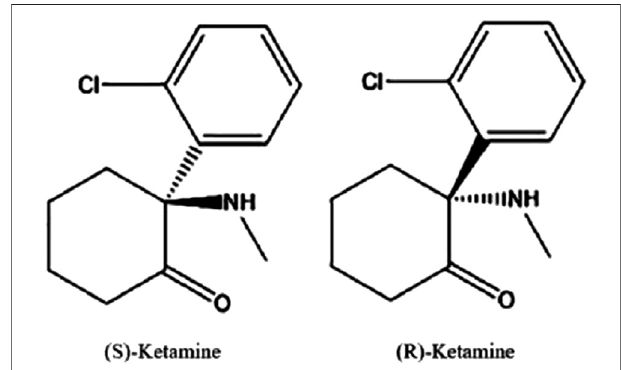
FIGURE 1 | Chemical structural of the two ketamine